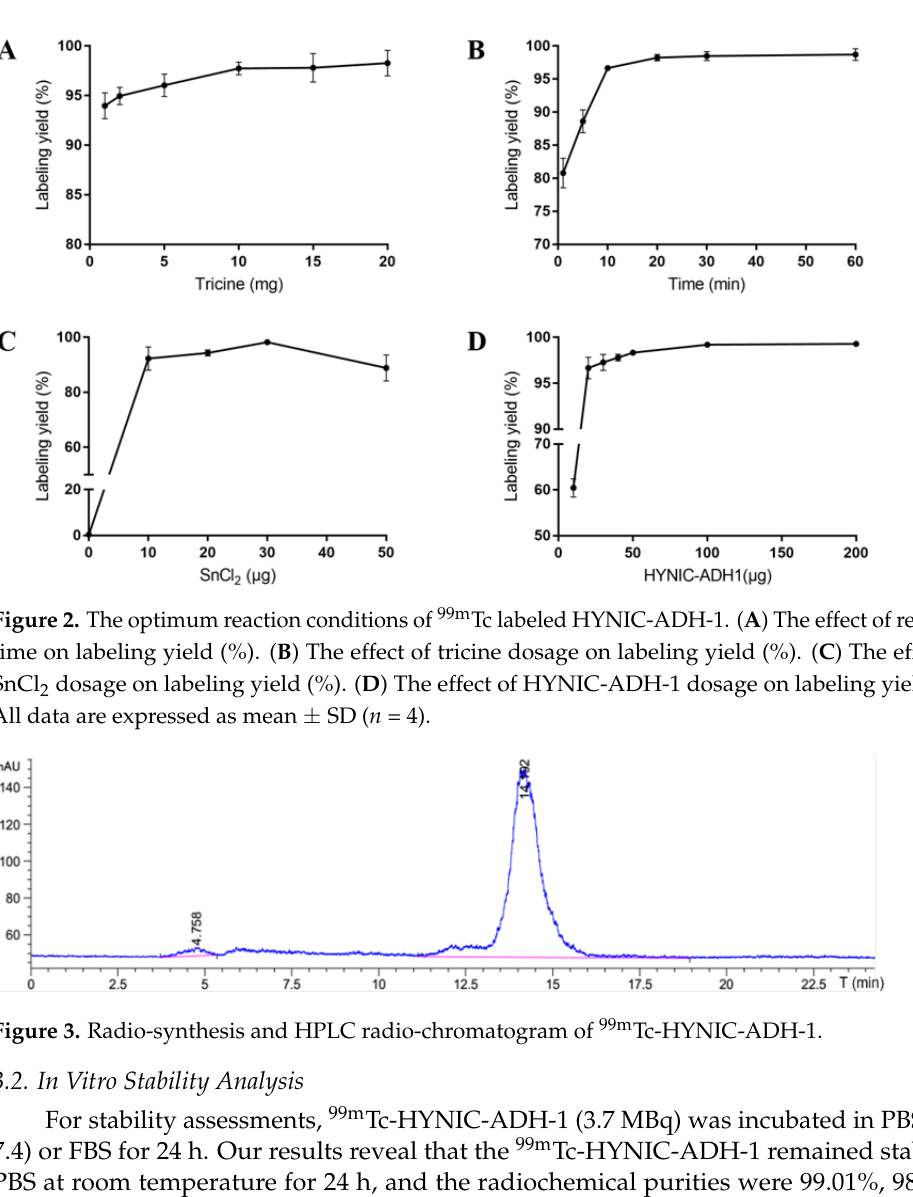
Figure 3. Radio-synthesis and HPLC radio -chromatogram of 99m Tc-HYNIC-ADH-1